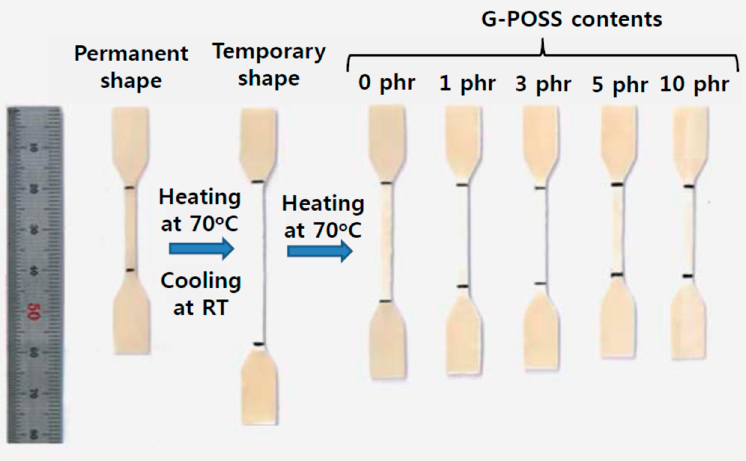
Figure 6. Thermally triggered shape memory procedure of samples with different POSS contents. Table 3. Shape memory properties of PA12/POE/G-POSS blend with different POSS contents.